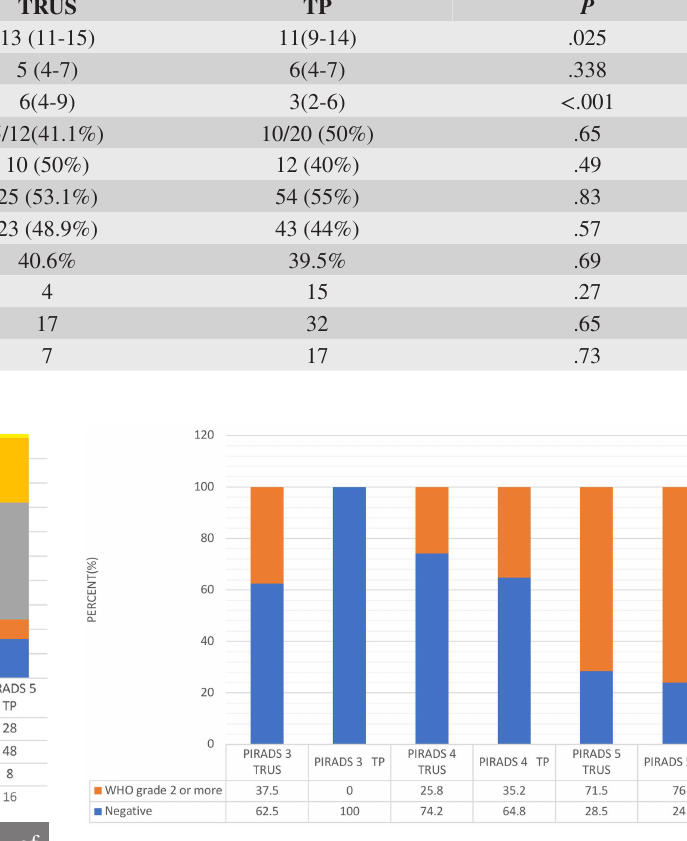
Figure 4. Detection rate of clinically significant cancer (WHO grade 2 or more) by PIRADS in the TP versus TRUS approach.